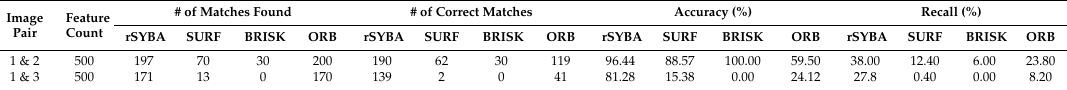
Table 3. Metrics Boat Image Sequence between Images 1 and 2 and Images 1 and